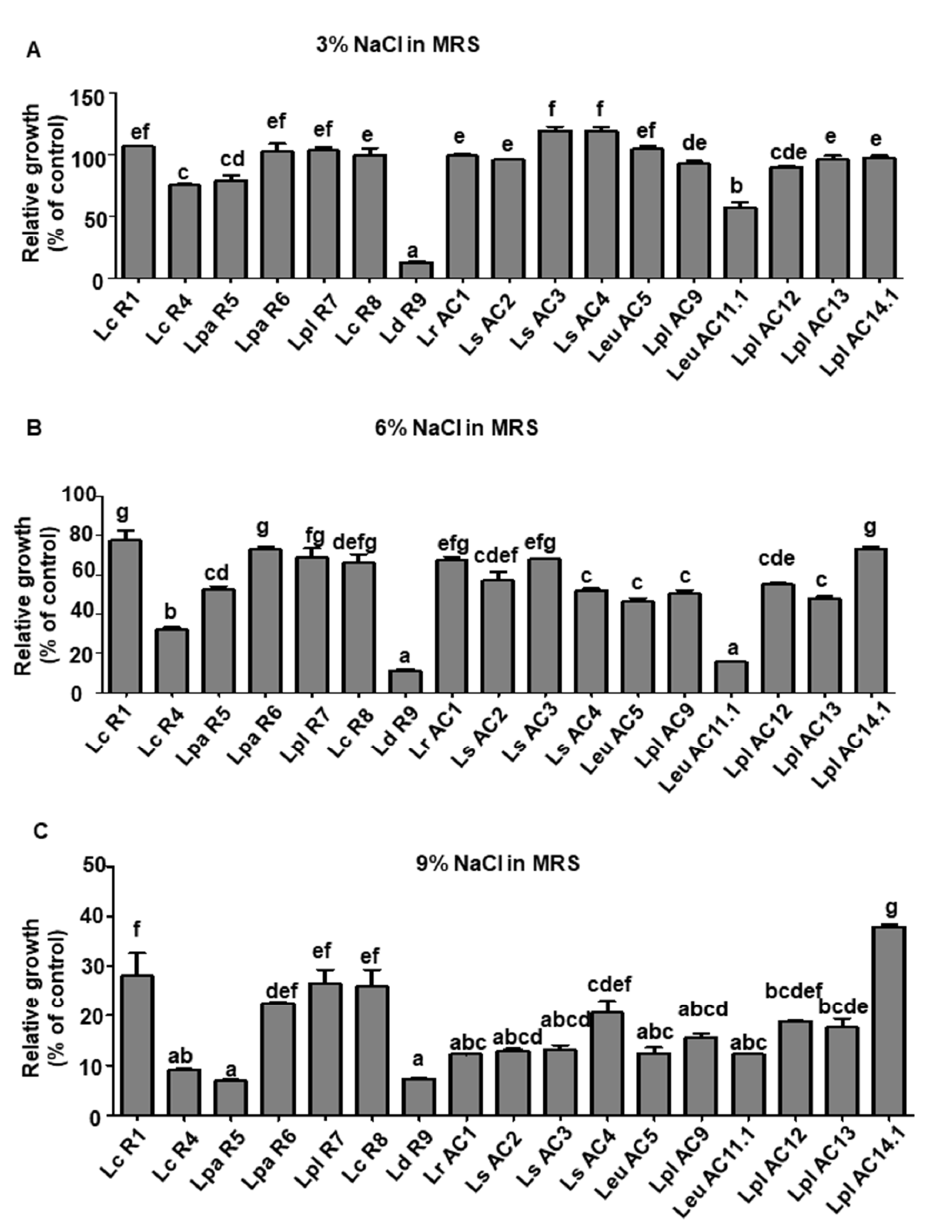
Figure 2. Relative growth of selected LAB isolates in the MRS broth supplemented with 3% ( A ), 6% ( B ), and 9% ( C ) NaCl for 24 h of incubation. Relative growth was determined by the ratio of OD 600 of LAB cultures grown in the MRS supplemented with different concentrations of NaCl to that in the regular MRS. Graph bars marked with different letters on top represent statistically significant results. The results were compared by one-way ANOVA and Turkey post hoc test; p < 0.05; n = 2. Lc, L. casei; La , L. acidophilus; Lpa , L. paracasei; Lpl , L. plantarum; Ld , L. delbrueckii; Lr , L. rhamnosus; Ls , L. sakei; Leu , Leu. mesenteroides.